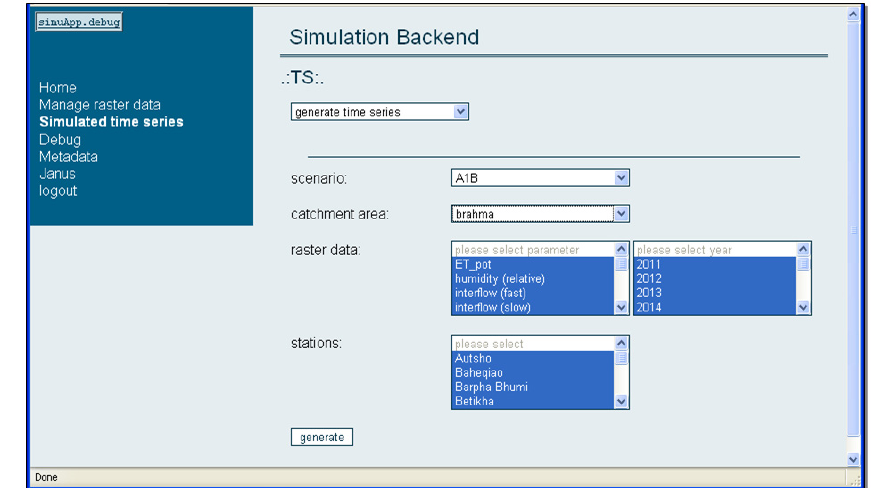
Figure 4. Registering new data to the